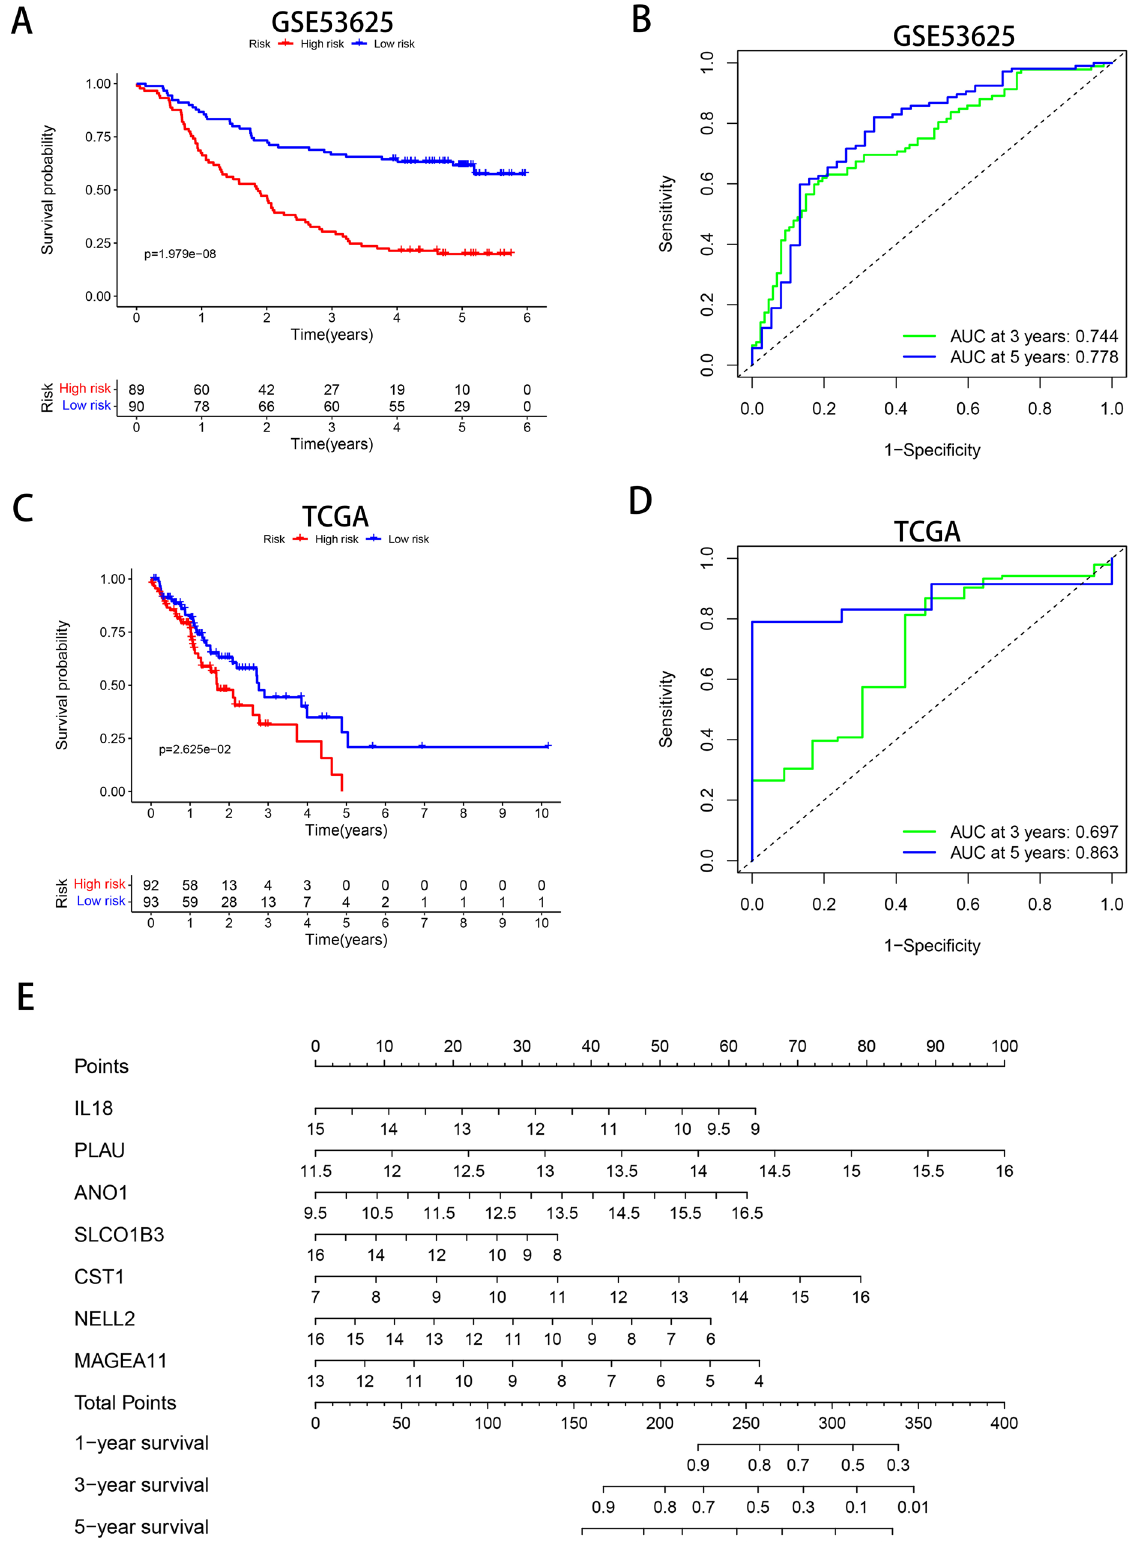
Figure 8. Analysis of the prognostic risk score model containing 7 prognostic genes in ESCC patients. ( A, C ) Kaplan–Meier survival analysis in the GSE53625 and TCGA cohorts (with patients grouped by the median risk score). ( B, D ) ROC curves for predicting 3- and 5-year OS based on the risk score in the GSE53625 and TCGA cohorts. ( E ) Nomogram for predicting the 1-, 3- and 5-year OS of ESCC patients in the GSE53625 cohort. ROC, receiver operating